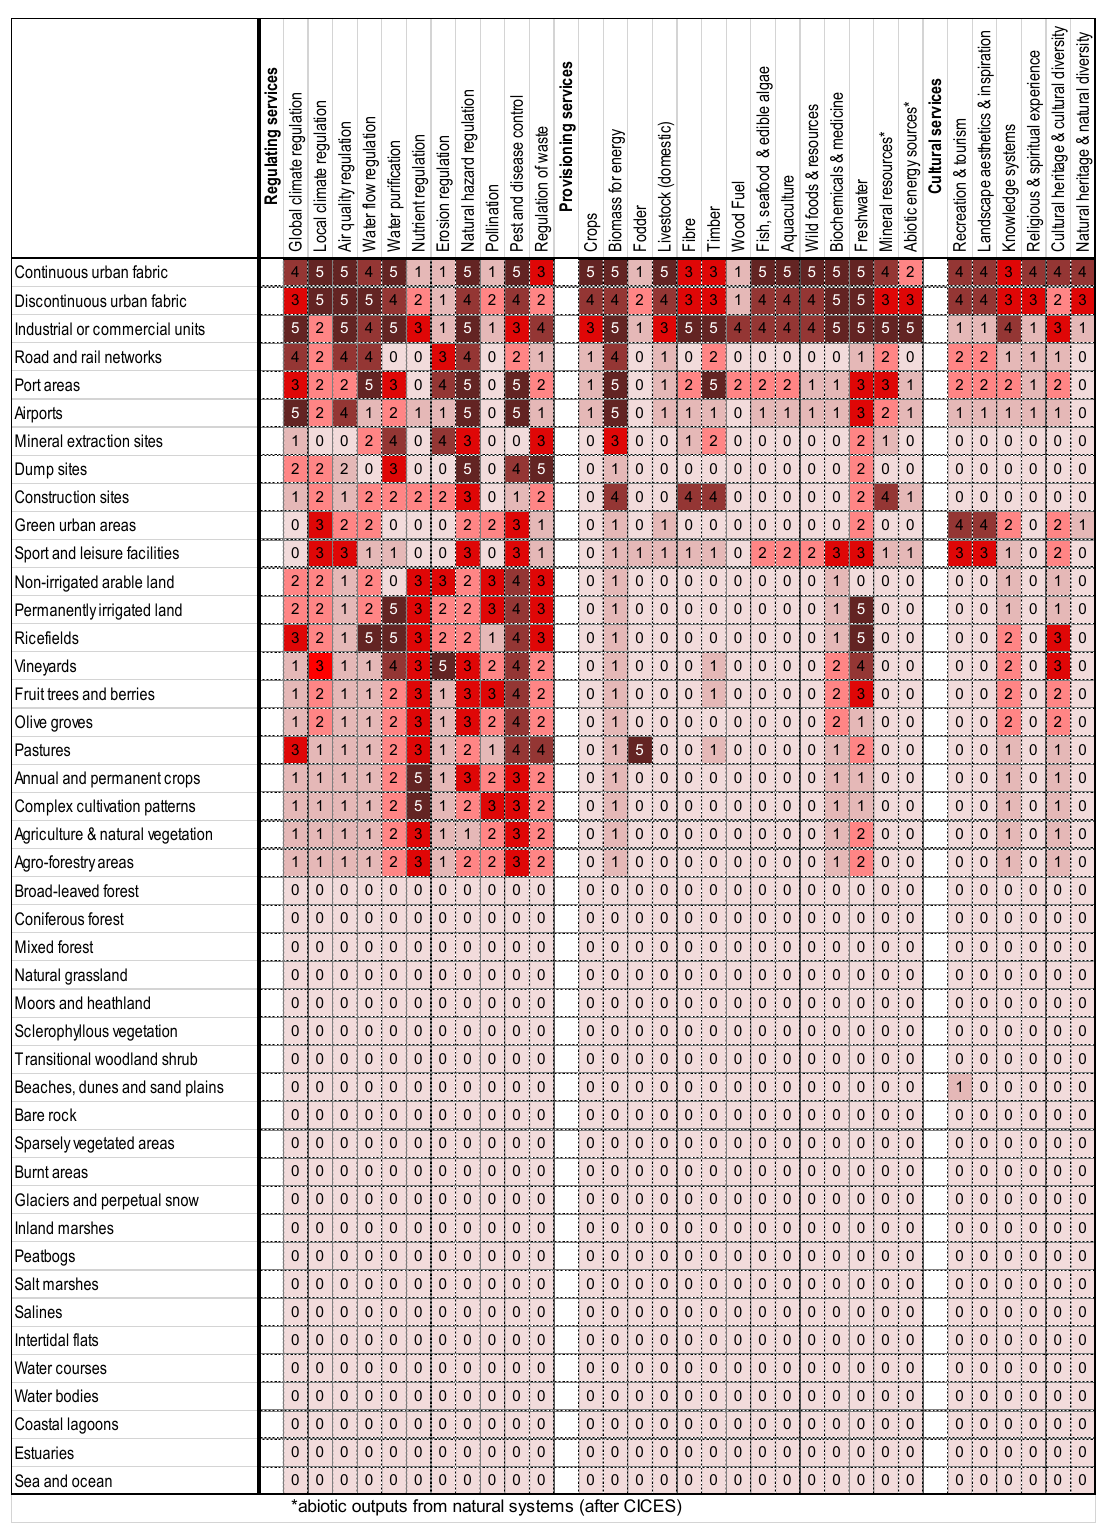
Figure 7: Exemplary ecosystem service matrix showing demands for ecosystem services within different land cover classes. The exemplary evaluation refers to a hypothetical European „normal“ landscape in summer (before the harvest period). Scale from: 0/rosy = no relevant demand; 1/dark rosy = low relevant demand; 2/light red = relevant demand; 3/red = medium relevant demand; 4/dark red = high relevant demand; and 5/brown red = very high relevant demand (after Burkhard et al.